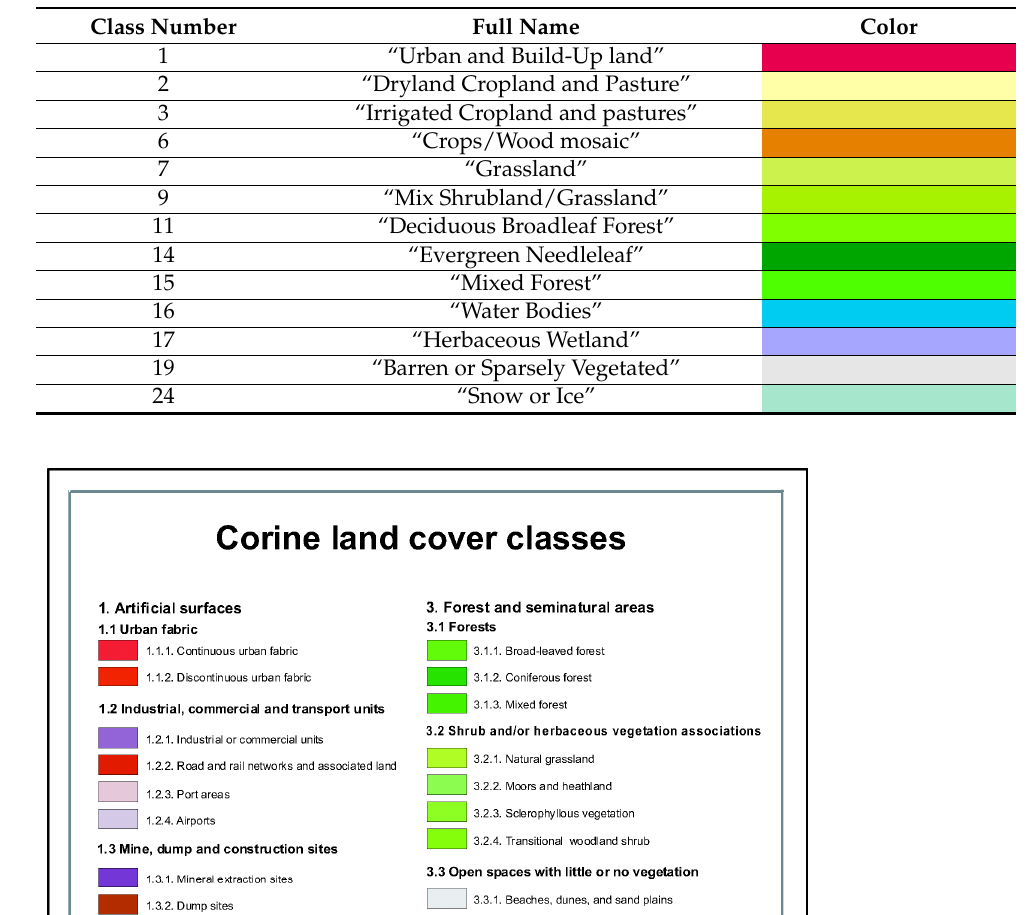
Table A2. USGS classes that are used by the CLC after the conversion of [47].